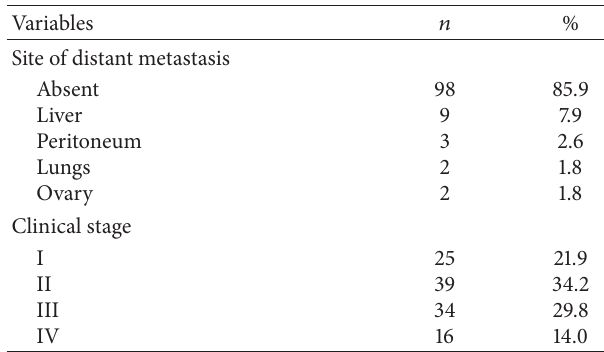
Table 1: Characteristics of the 114 patients included in the study. Table 1: